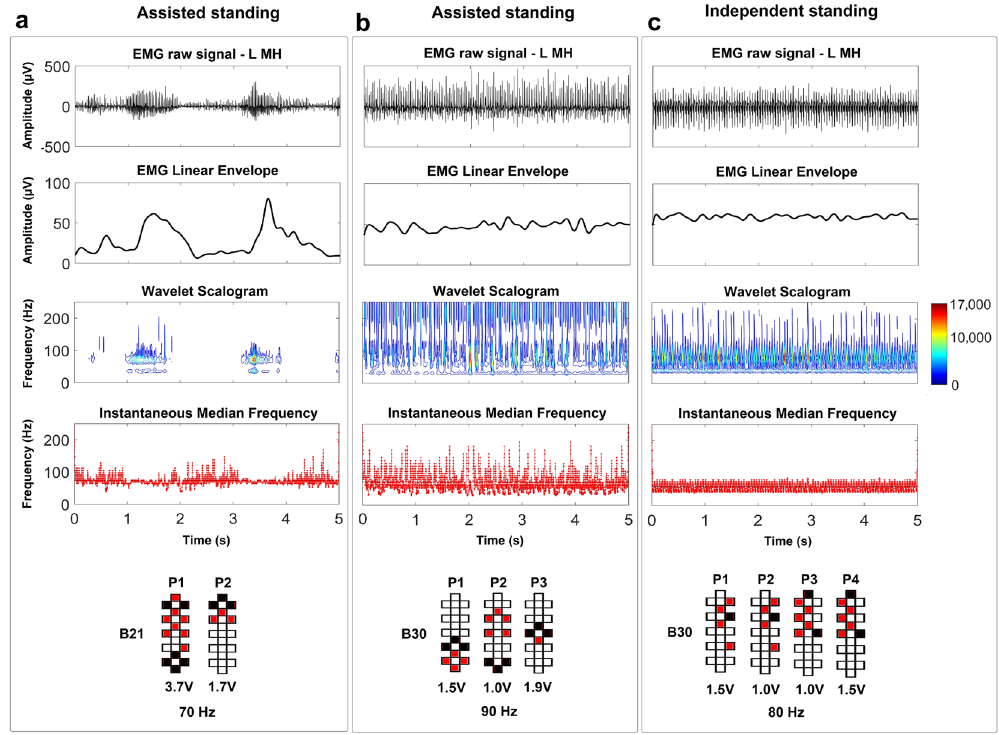
Figure 4. EMG-time and –frequency features characterizing exemplary standing activation patterns. EMG activity recorded from the left medial hamstrings (L MH) during standing with self-assistance for balance and external assistance for hip and knee extension characterized by ( a ) EMG bursts or by ( b) continuous EMG activity, as well as ( c ) during independent standing with self-assistance for balance. For each standing condition, the EMG linear envelope, time-frequency power distribution of the signal (wavelet scalogram), and instantaneous median frequency are calculated from the plotted raw EMG. The wavelet scalogram is presented as contour plots, the power values of which are represented as colormaps, with the color scale showing the range of power values. Stimulation amplitude, frequency and electrode configuration (cathodes in black, anodes in red, and inactive in white) are reported. EMG activity reported in Panel A was collected from research participant B21. EMG activity reported in Panels B and C was collected from research participant